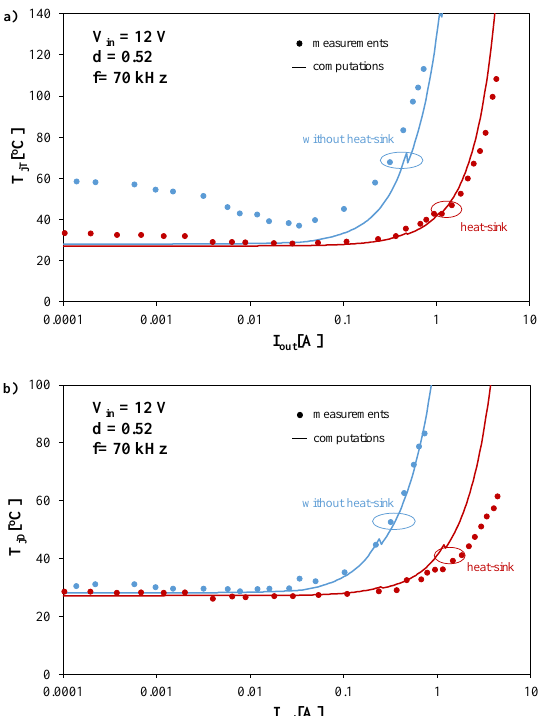
Figure 6. Measured and computed dependences of the IGBT junction temperature ( a ) and the diode junction temperature ( b ) on the output current of the investigated converter.